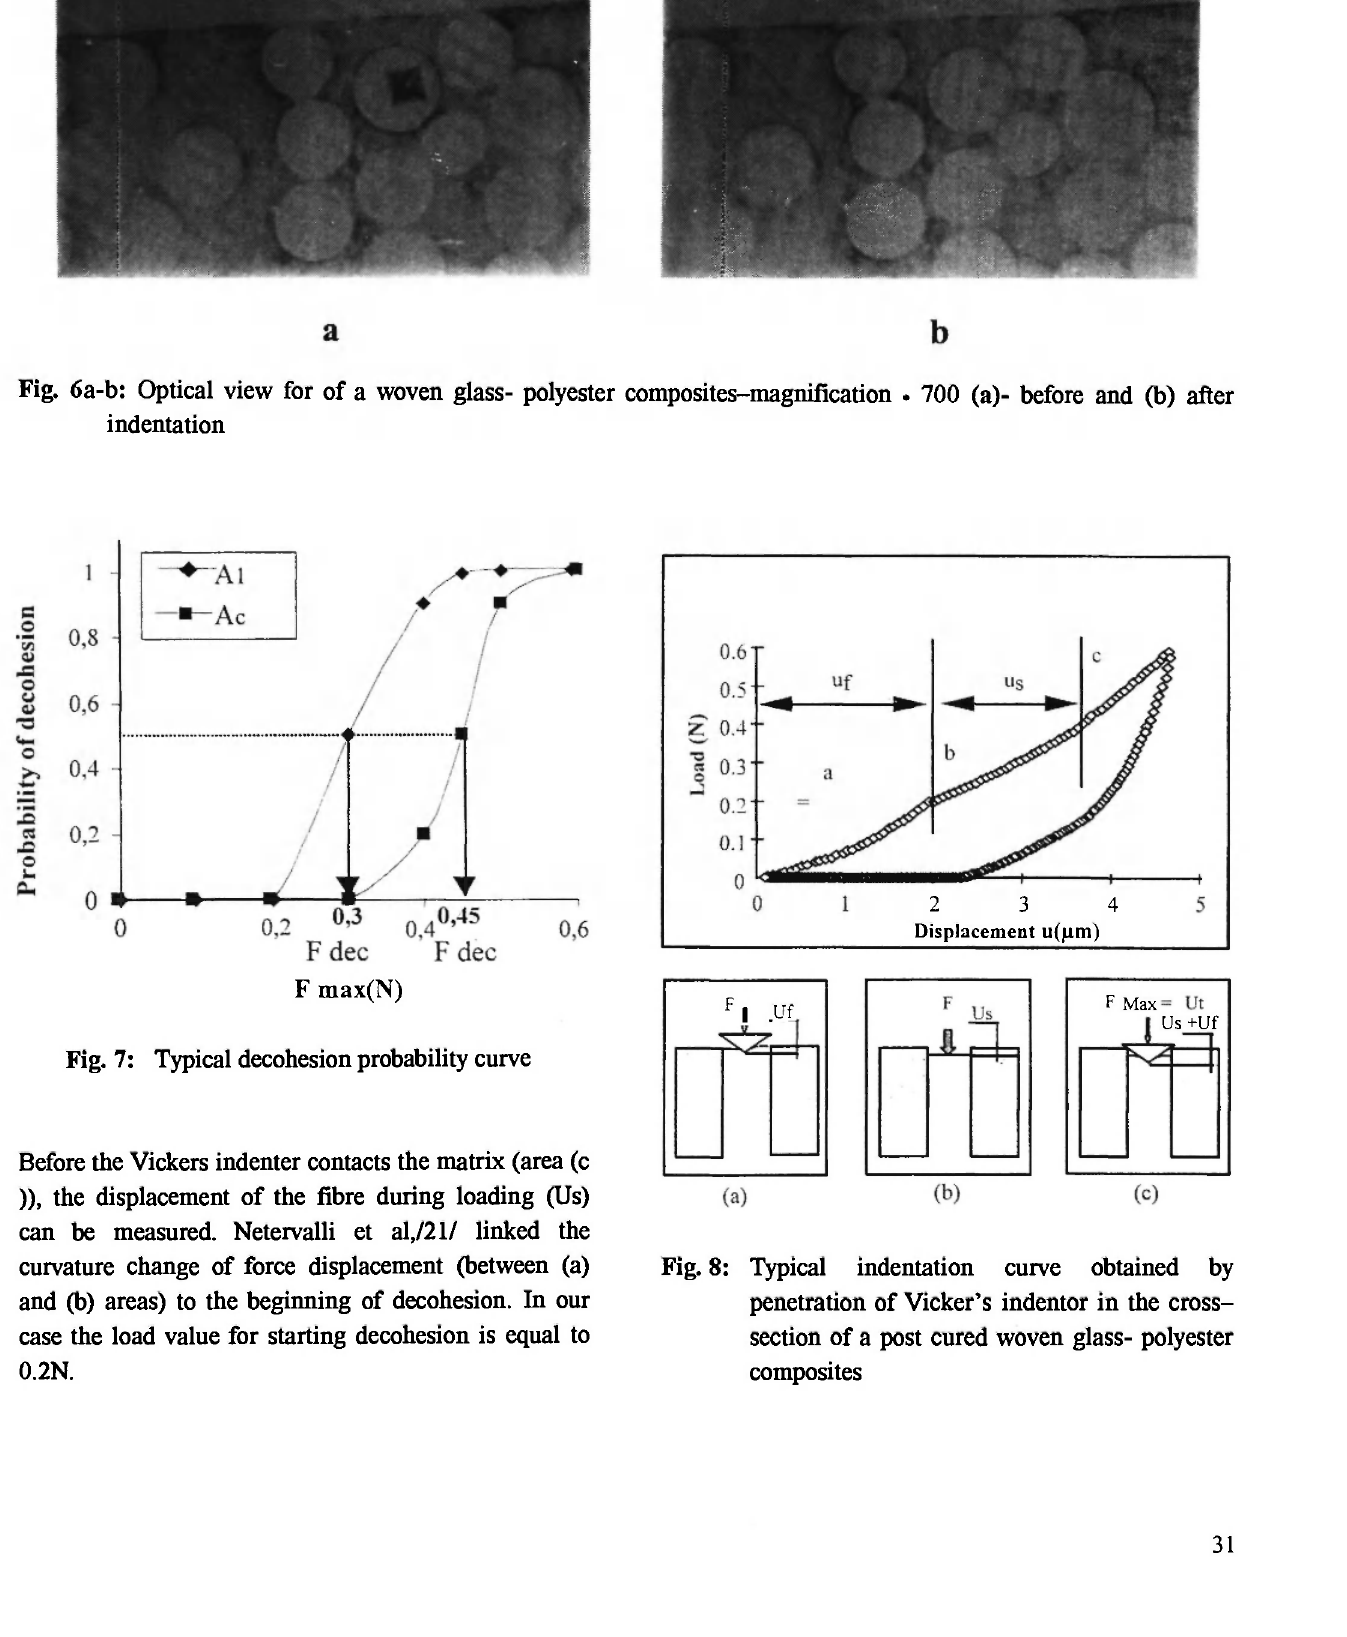
Fig. 6a-b: Optical view for of a woven glass- polyester composites-magnification . 700 (a)- before and (b) after indentation